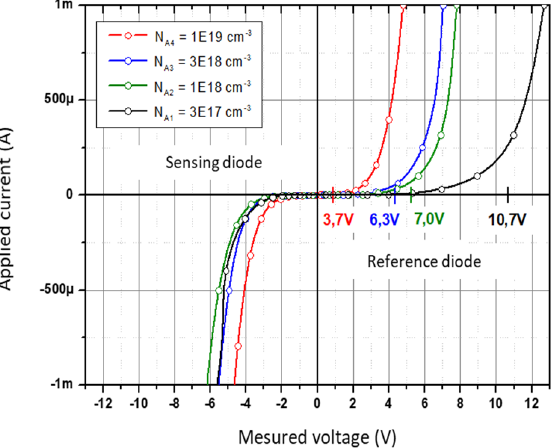
Figure 7. Electrical characterization of pair of Zener diodes with different initial doping level.